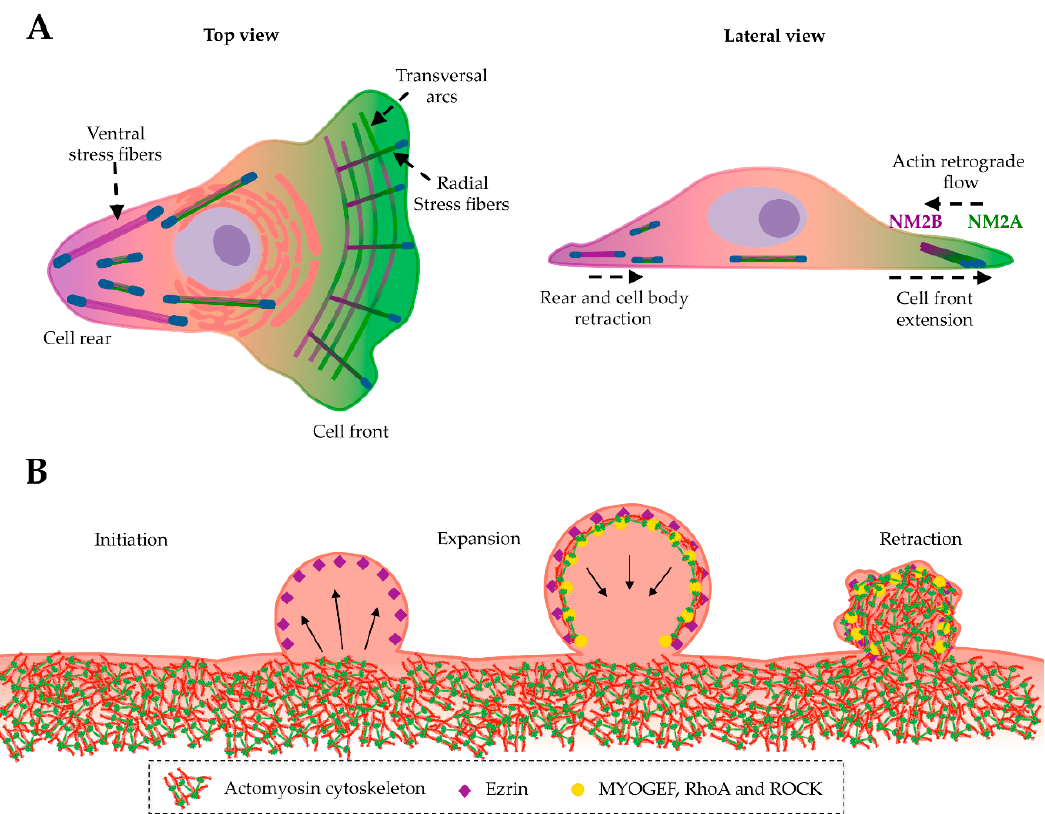
Figure 6. Involvement of NM2A in cell migration and plasma membrane blebbing. ( A ) Scheme showing a cell migrating in a 2D environment, top and lateral views are represented. To migrate in a 2D environment the cell polarizes in the front and rear regions, which are defined by an intracellular gradient of proteins and allow directionality during movement. NM2 isoforms play a key role in 2D migration and are selectively localized at di ff erent cell regions. NM2A concentrates at the cell front where high actin dynamics are taking place, and gradually decreases towards the rear where NM2B is concentrated. In between cell poles (front and rear) NM2A and NM2B co-exist at di ff erent concentrations in mixed actomyosin filaments. Focal adhesions at the extremities of stress fibers are shown as blue circles. ( B ) Process of plasma membrane bleb formation and retraction. Upon stimuli (e.g., apoptosis and calcium influx), a membrane protrusion forms (bleb initiation) due to the plasma membrane detachment from the cortical cytoskeleton. As a result of intracellular pressure, the bleb swells (bleb expansion) until ezrin recruits cytoskeletal proteins that promote actin polymerization and the subsequent interaction with NM2A. NM2A contractile forces pull the membrane inwards and support bleb